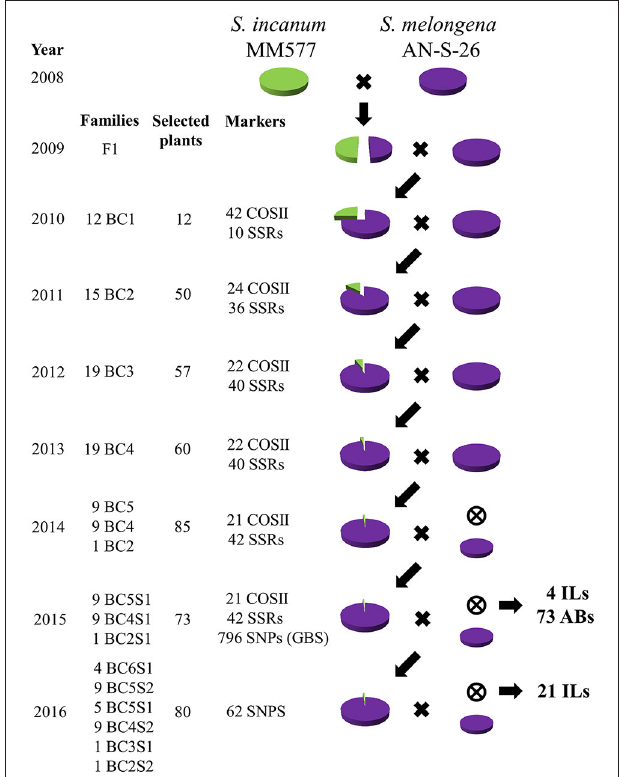
FIGURE 2 | Breeding scheme used to develop the first set of eggplant ABs and ILs in the genetic background of Solanum melongena AN-S-26 (purple circle) by using S. incanum MM577 (green circle) as a donor. For each year (one generation per year), the number of families, selected plants, molecular markers assessed and type of cross are shown, the backcrosses with the recurrent parents are represented by an × and a purple circle, and the selfing rounds by an encircled ×